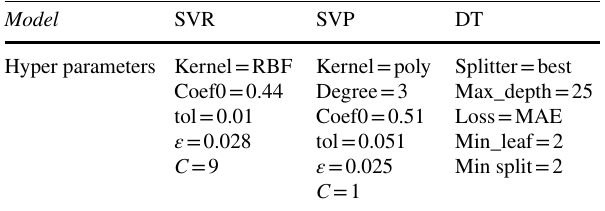
Fig. 6 Visualization of the hyper parameter optimization for the XGBoost regressor Table 2 Utilized Hyper-parameters for base models